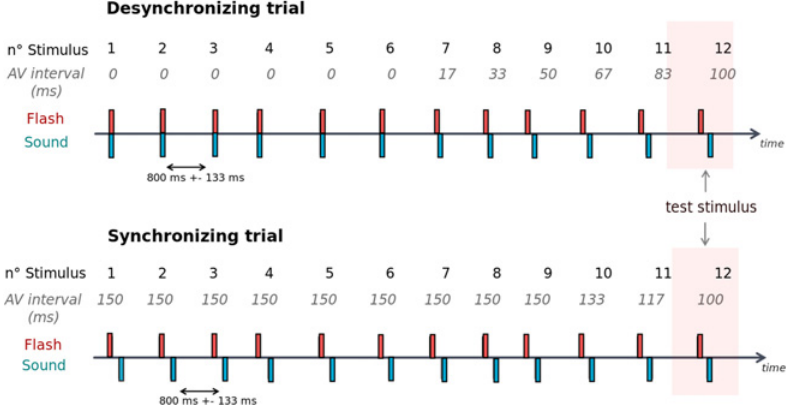
Fig 1. Illustration of Desynchronizing and Synchronizing trials. For illustration, the AV intervals presented here refer to flash-leads asynchronies; note that both flash-leads and sound-leads asynchronies were tested in the study. One trial was systematically composed of 12 successive AV stimuli: the first 11 stimuli consisted in the adaptation sequence and the 12th stimulus was the test stimulus. Participants were asked to report whether the test stimulus was synchronous or asynchronous. In the Desynchronizing trials (upper panel), the first AV stimulus was always synchronous and progressively desynchronized in steps of 16.7 ms until a specified AV interval at the 12 th position (e.g. 100 ms in this example). During the Synchronizing trials (lower panel), the first AV stimulus was always asynchronous (150 ms lag) and progressively synchronized in steps of 16.7 ms until a specified AV interval at the 12 th position (here, 100 ms). Crucially, the AV interval of the test stimulus (12 th position) was identical in Desynchronizing and Synchronizing trials although the initial interval was either 0 or 150 ms,